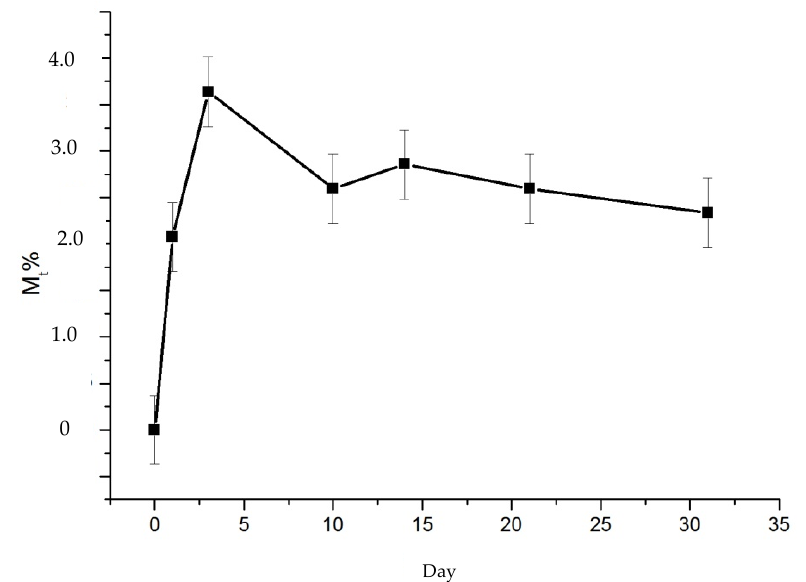
Figure 11. Trend of sample mass at 1000 rpm as aging time increases .